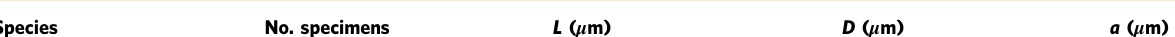
Table 1 Summary of specimen geometry for Ea . and Ta . spicules. imaged the spicule using the FIB and measured the diameter of